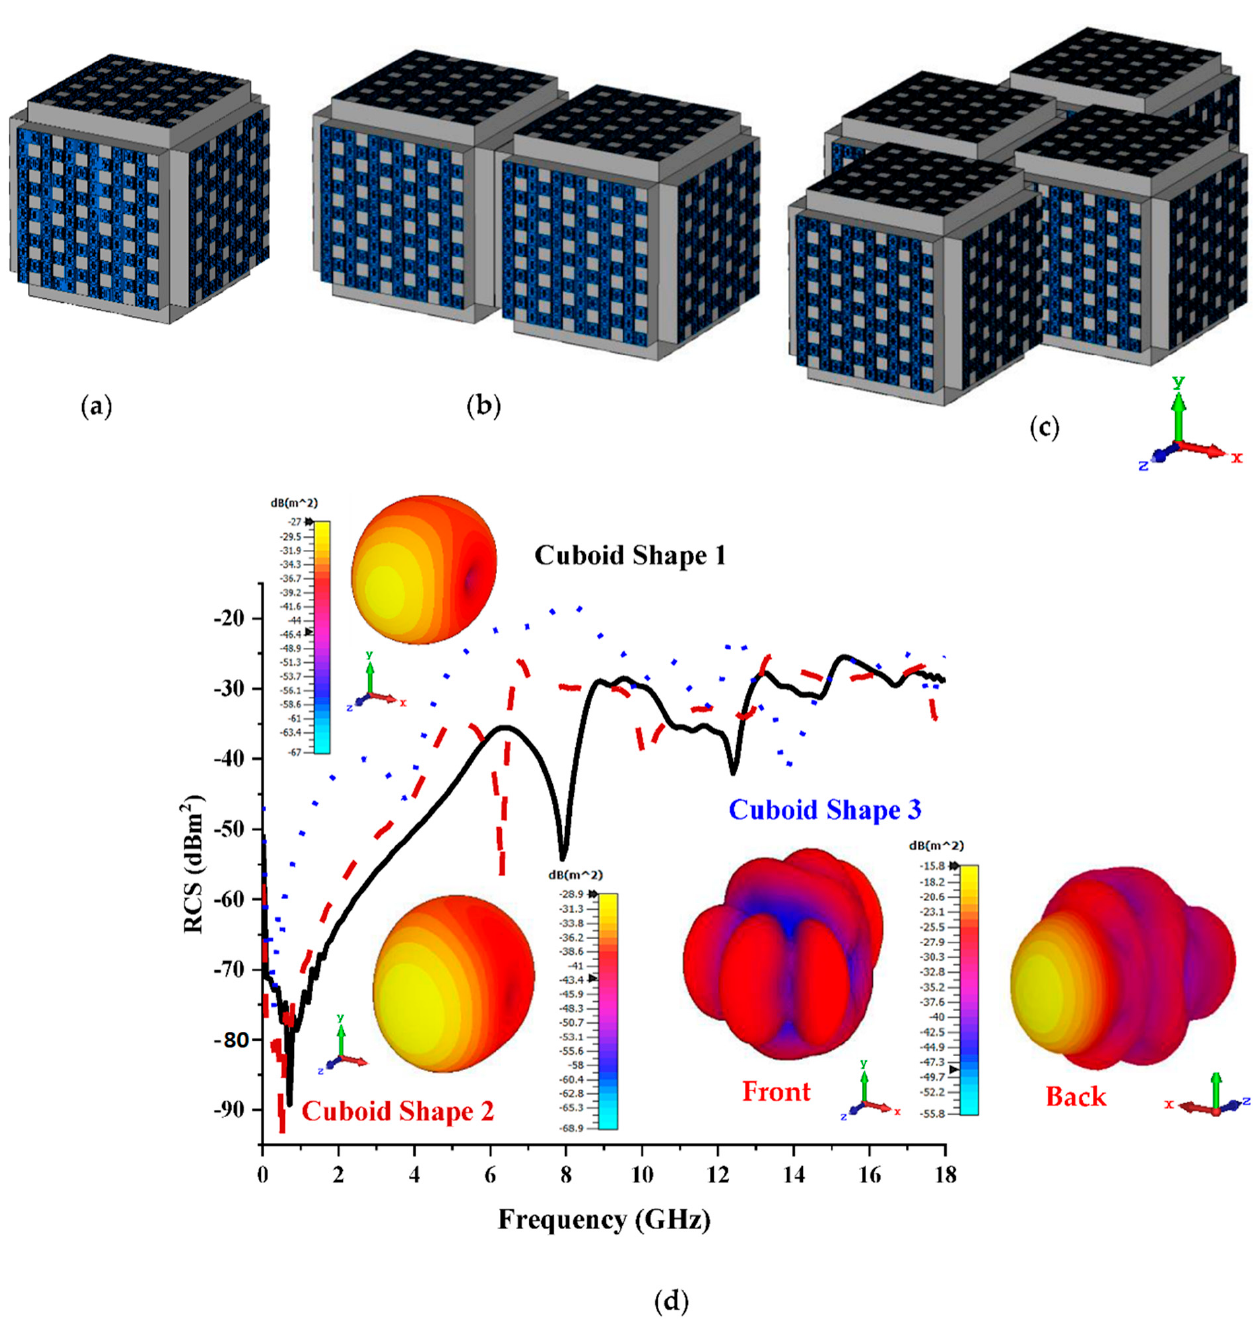
Figure 8. Twelve lattices: ( a ) Cuboid Shape 1; ( b ) Cuboid Shape 2; ( c ) Coding Shape 3; ( d ) monostatic RCS and bistatic scattering pattern at 15 GHz.